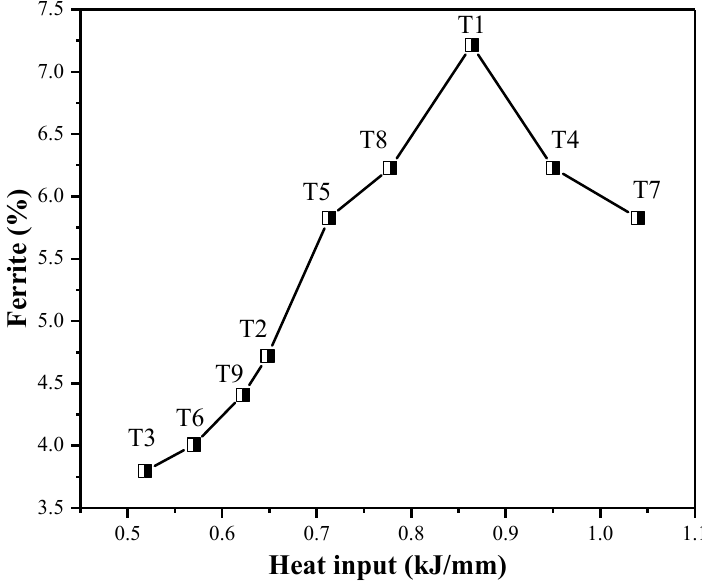
Figure 3. Ferrite content in welds with different heat input.